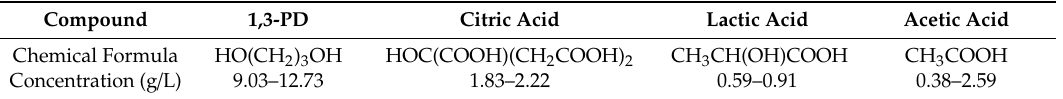
Table 3. The compounds concentration in 1,3-propanodiol (1,3-PD) post-fermentation solutions with Citrobacter freundii bacteria.